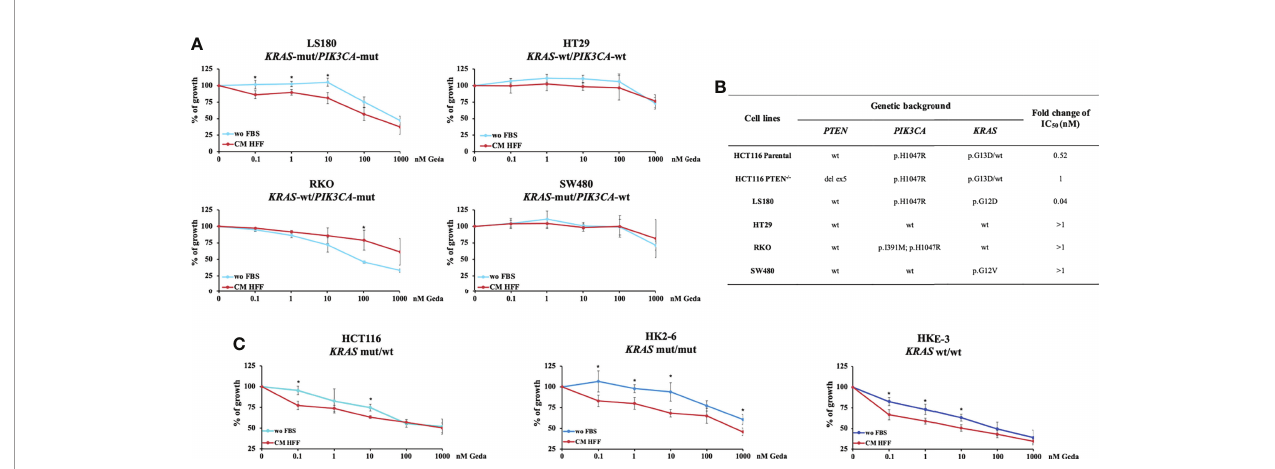
FIGURE 2 | Fibroblast-CM-dependent sensitivity to Geda occurs only in KRAS -mut/ PIK3CA -mut/PTEN-competent CRC cell lines. PTEN-competent LS180, HT29, RKO and SW480 cell lines and isogenic KRAS HCT116 cell lines (HCT116, HK2-6 and HKE-3) were treated with increasing doses of Geda (range doses 0.1-1000 nM) in serum-free condition and fi broblast HFF-CM ( A , C , respectively). Results are expressed as percentage of growth inhibition relative to untreated control and represent the average ± SEM of three independent experiments. Asterisks indicate statistically signi fi cant differences (p-value < 0.05 by 2-tailed Student ’ s t test) for the comparison between treatment under wo FBS and HFF CM conditions. (B) Ratio of IC 50 of Geda (nM) under CM HFF vs wo FBS condition of